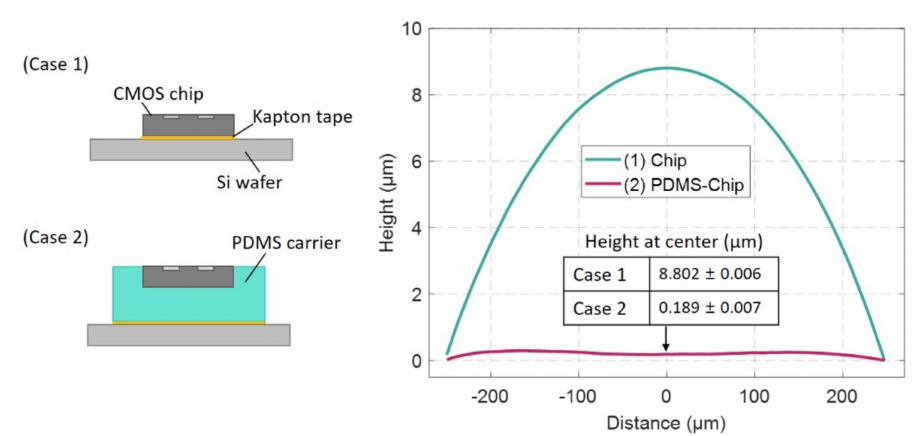
Figure 3. Comparing the surface profiles microchips coated by a 3.5 µ m-thick photoresist film, without (case 1) and with the planarization process (case 2). Both samples were spin-coated at 3000 rpm for 60 s and baked in the oven at 90 ◦ C for 30 min. The unprocessed and PDMS-planarized chips (650 µ m × 650 µ m × 200 µ m) were attached on the silicon wafer using a double-side Kapton